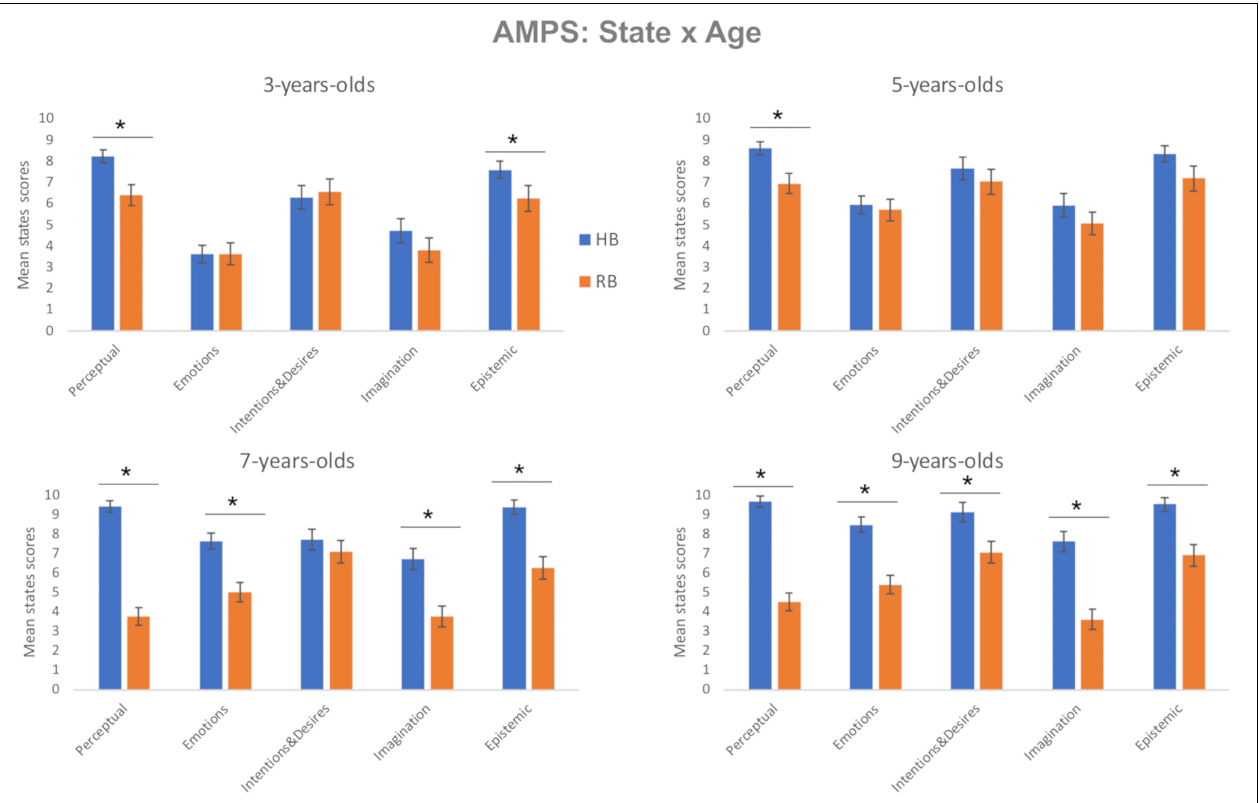
FIGURE 3 | Children’s scores on the Attribution of Mental States (AMS) scale. AMS mean scores for the human (HB = blue bar) and the robot (RB = orange bar) for each age group (3-, 5-, 7-, and 9-year-olds) as a function of state (Perceptual, Emotions, Intentions and Desires, Imagination, Epistemic). The bars represent the standard error of the mean. * indicates significant